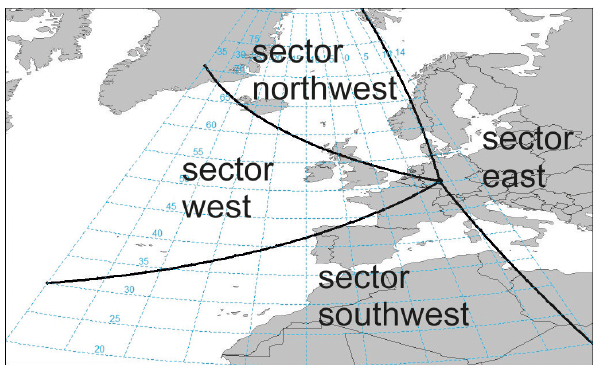
Figure 10. Sectoral classification of air mass trajectories. Black lines indicate sector boundaries; trajectories are attributed to a sec- tor if more than 50% of travel time is spent within.